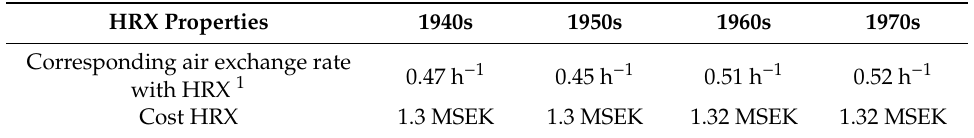
Table 9. Air exchange rate before and after installation of an heat recovery ventilation (HRX) system, and the cost of the new ventailtion